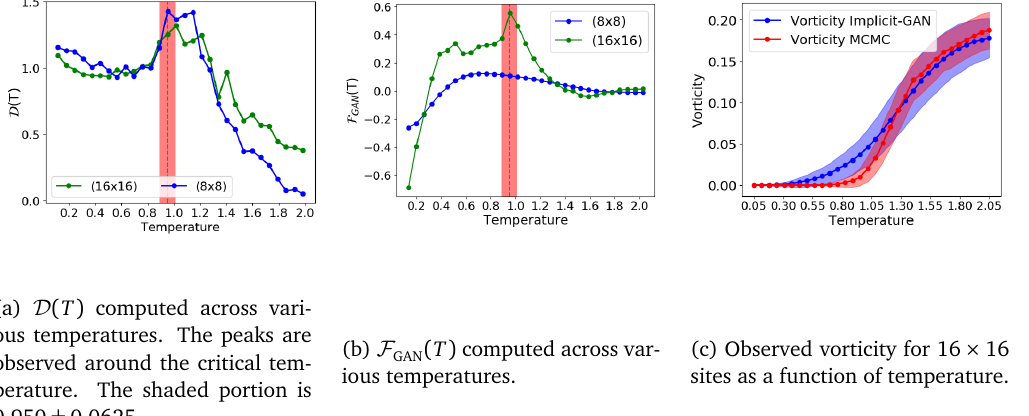
Figure 3: Detection of BKT phase transition (a,b) directly from measures defined in terms of the networks (unsupervised) and (c) by evaluation of the vorticity of generated